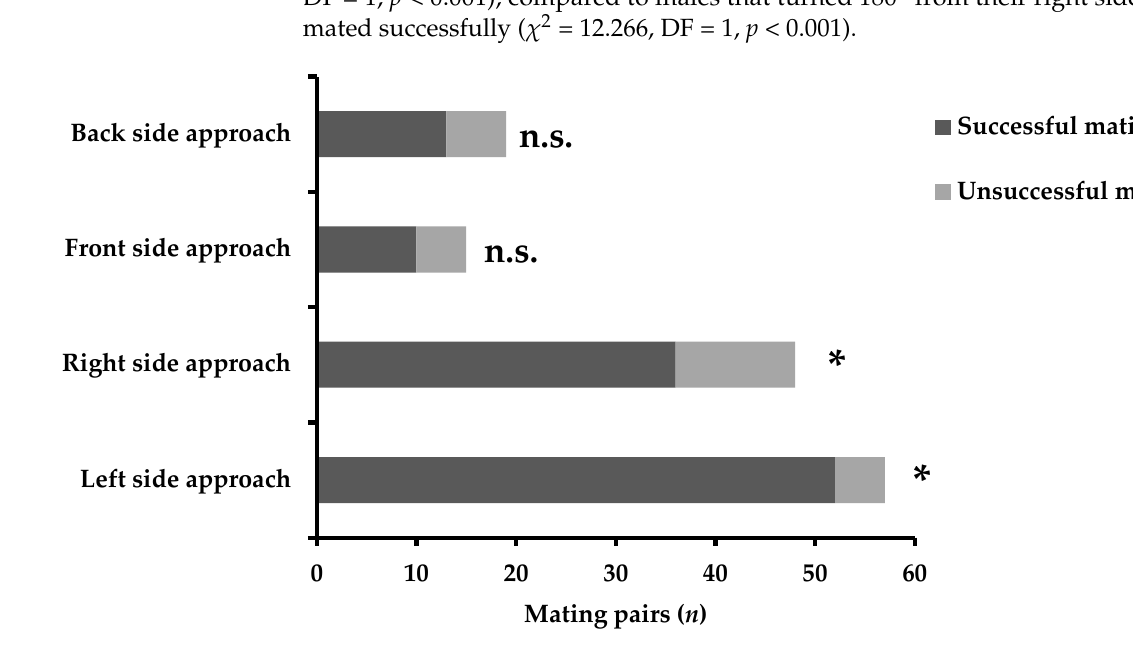
Figure 2. Male mating success of Cryptolestes ferrugineus exhibiting or not exhibiting lateralized approaches towards females. The asterisk indicates significant differences; n.s. = not significant (generalized linear model, binomial distribution, p < 0.01).